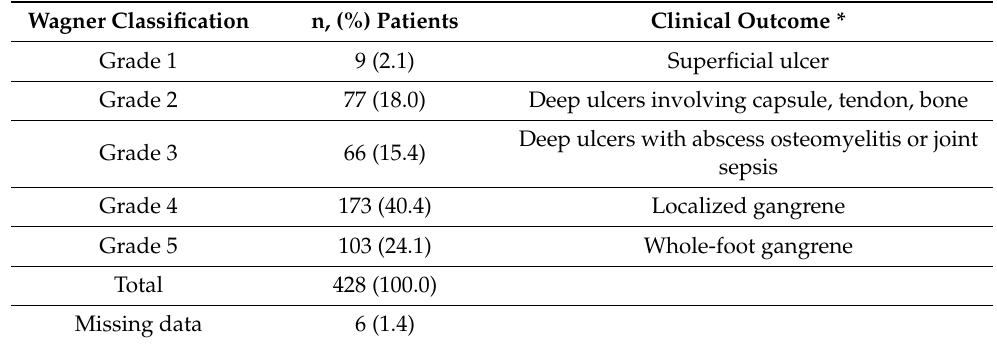
Table 4. Distribution of patients regarding Wagner